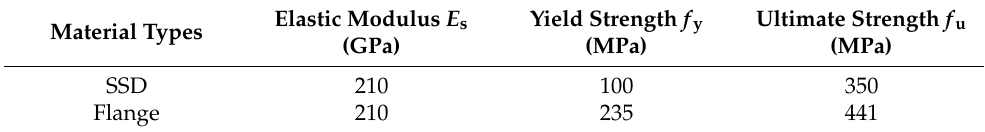
LS-1: Arranged CSSDB system on the bottom floor of MD-RC frame (Figure 8a); • LS-2: Arranged CSSDB system on the first and second floors of MD-RC frame (Figure 8b); and, • LS-3: Arranged CSSDB system on all floors of MD-RC frame (Figure 8c). Figure 8 shows the layout information and detailed size of CSSDB system. In all of the CSSDB systems, the CSSD device is attached to the steel plates at the top and bottom using the welded connections. The steel plates and H-beams are made of Q345 steel with a Young’s modulus of 206 GPa, yielding strength of 345 MPa, and Poisson’s ratio of 0.3. In these retrofitting systems, the connections of steel plates and beam-column are welding. Rigid connection between CSSDB systems and concrete beam-column is assumed, and the influence of slippage and peeling between steel plates and concretes are neglected.